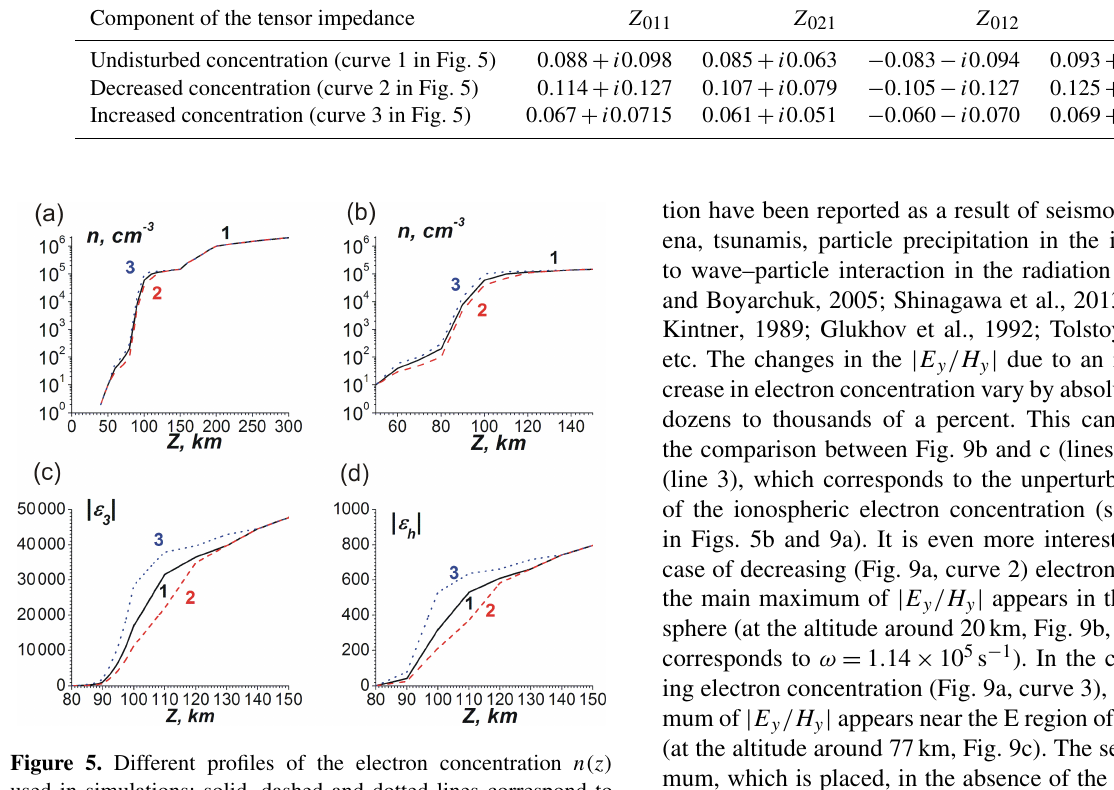
Figure 5. Different profiles of the electron concentration n(z) used in simulations: solid, dashed and dotted lines correspond to undisturbed, decreased and increased concentrations, respectively. Shown are the (a) detailed view and (b) general view. Panels (c) and (d) show the permittivity | ε 3 | and ε h